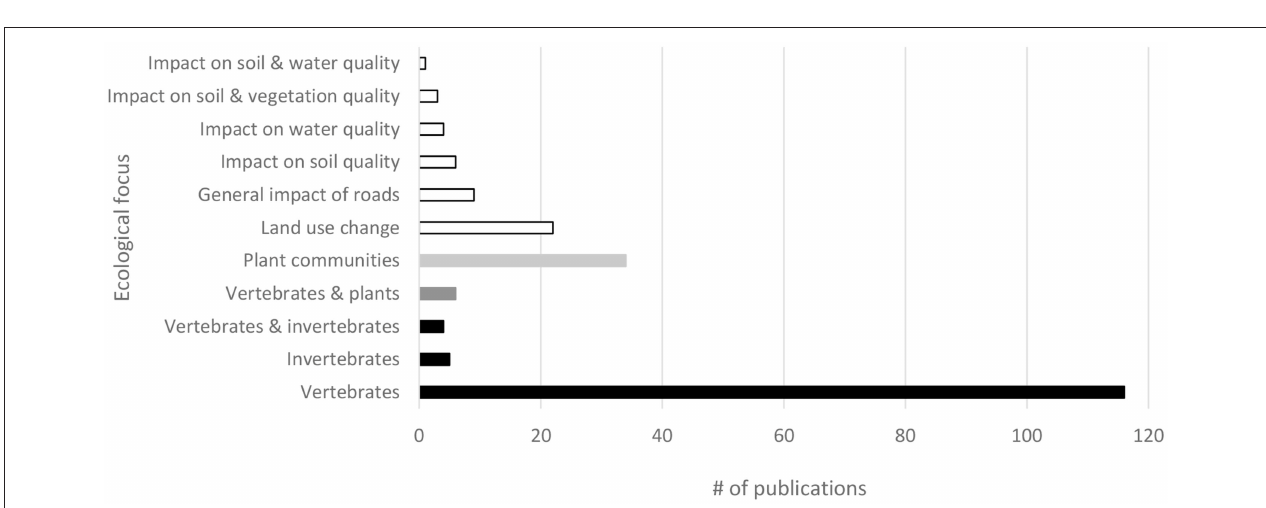
FIGURE 6 | The ecological focus of 210 road ecology publications, according to broad ecological groupings ( black bars represent animals, dark grey bars represent animals and plants, light grey bars represent plants and white bars represent ecosystems).